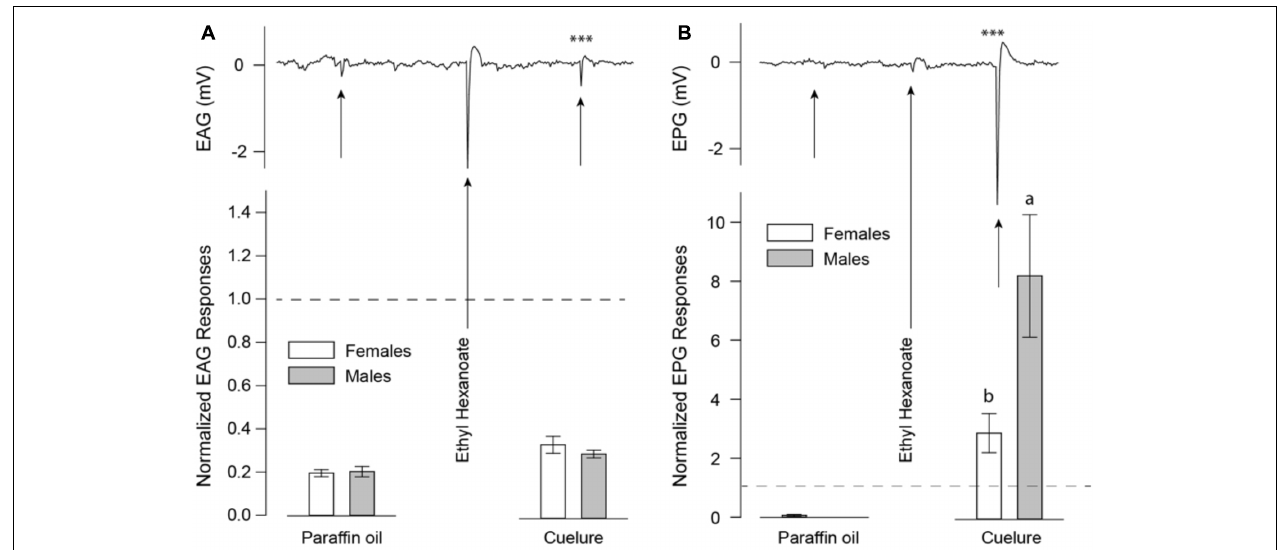
FIGURE 2 | Electroantennogram (EAG) (A) and electropalpogram (EPG) (B) of Bactrocera tryoni responding to paraffin oil as a blank control, ethyl hexanoate as a positive control, and cuelure. Black arrows on the EAG ( n = 8) and EPG ( n = 7) traces indicate chemical stimulations. White bars represent normalized responses of adult females and gray bars that of males with their standard errors. Letters above bars indicate statistical differences between male and female responses. Asterisks over the traces depict statistical differences of normalized responses compared with responses elicited by paraffin oil alone ( ∗∗∗ P < 0.001). Dashed lines indicate baseline response of ethyl hexanoate used as positive control and reference for data normalization.